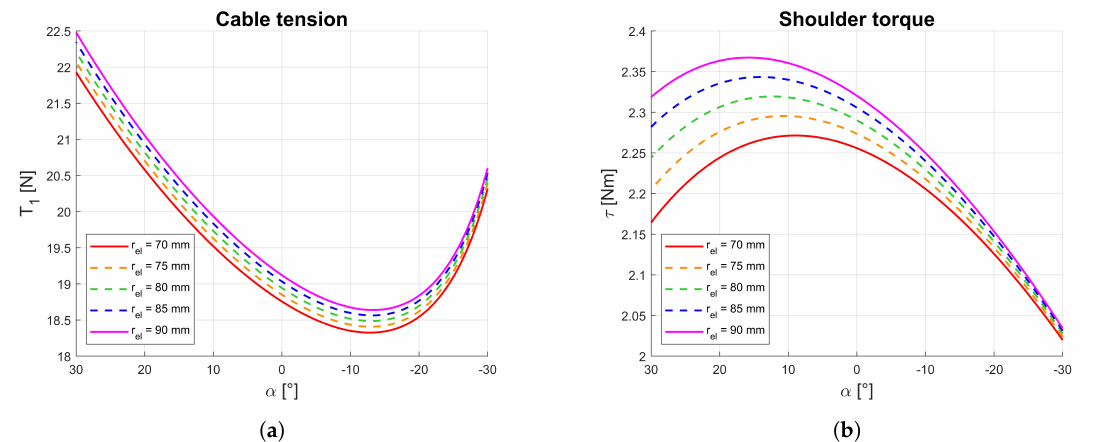
Figure 8. Computed results of the simulated operation of CADEL.3 in Figure 6 for bending elbow motion with T 2 = 5 N and M = 3.5 Nm when the elbow width increases in terms of r el : ( a ) cable tension; ( b ) shoulder